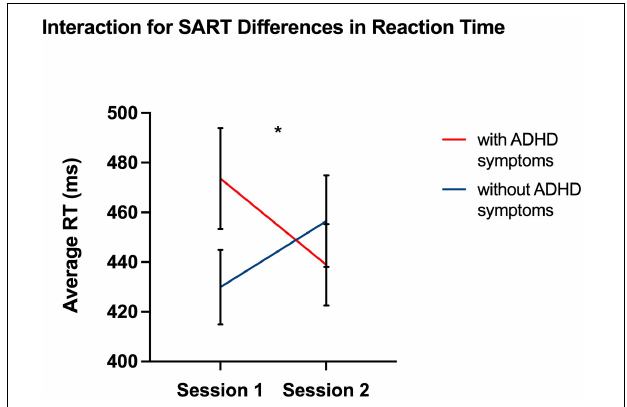
FIGURE 2 | Significant differences in response latency, at p < 0.05, between Session 1 and 2 indicate a greater magnitude of the synchrony effect for individuals with ADHD compared to neuro-typical individuals. * p < 0.05, two-tailed.